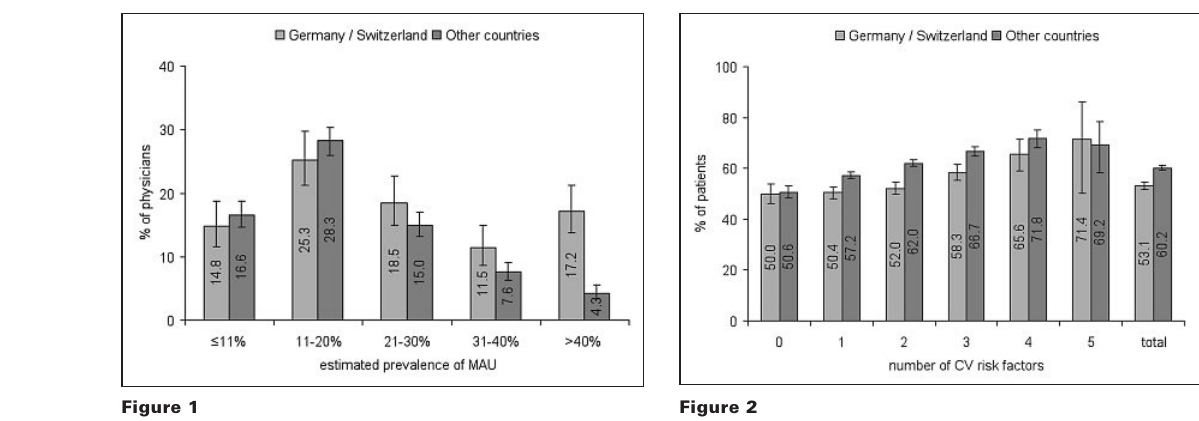
(+2.7%) were more frequently prescribed in pa- tients with MAU compared to patients without (fig. 4). The number of patients showing MAU when receiving pharmacotherapy was in the order CCBs > ACE Inhibitors > thiazides diuretics > beta blockers > ARBs (fig. 5).